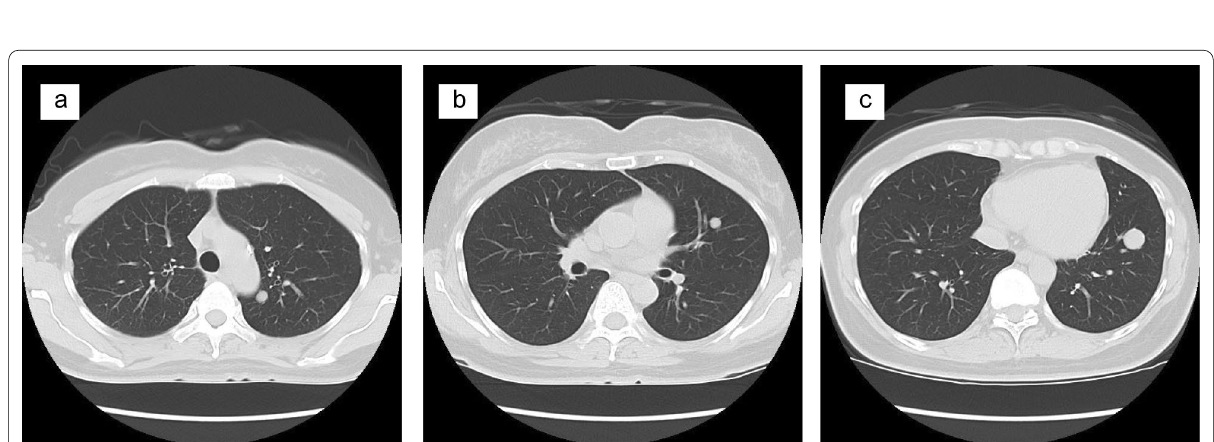
Fig. 3 CT imaging of metastases, 10 years after first resection. a CT shows 8-mm nodular shadow on the upper left lobe; b another 8-mm nodular shadow on the upper left lobe; c 15-mm nodular shadow on the lower left